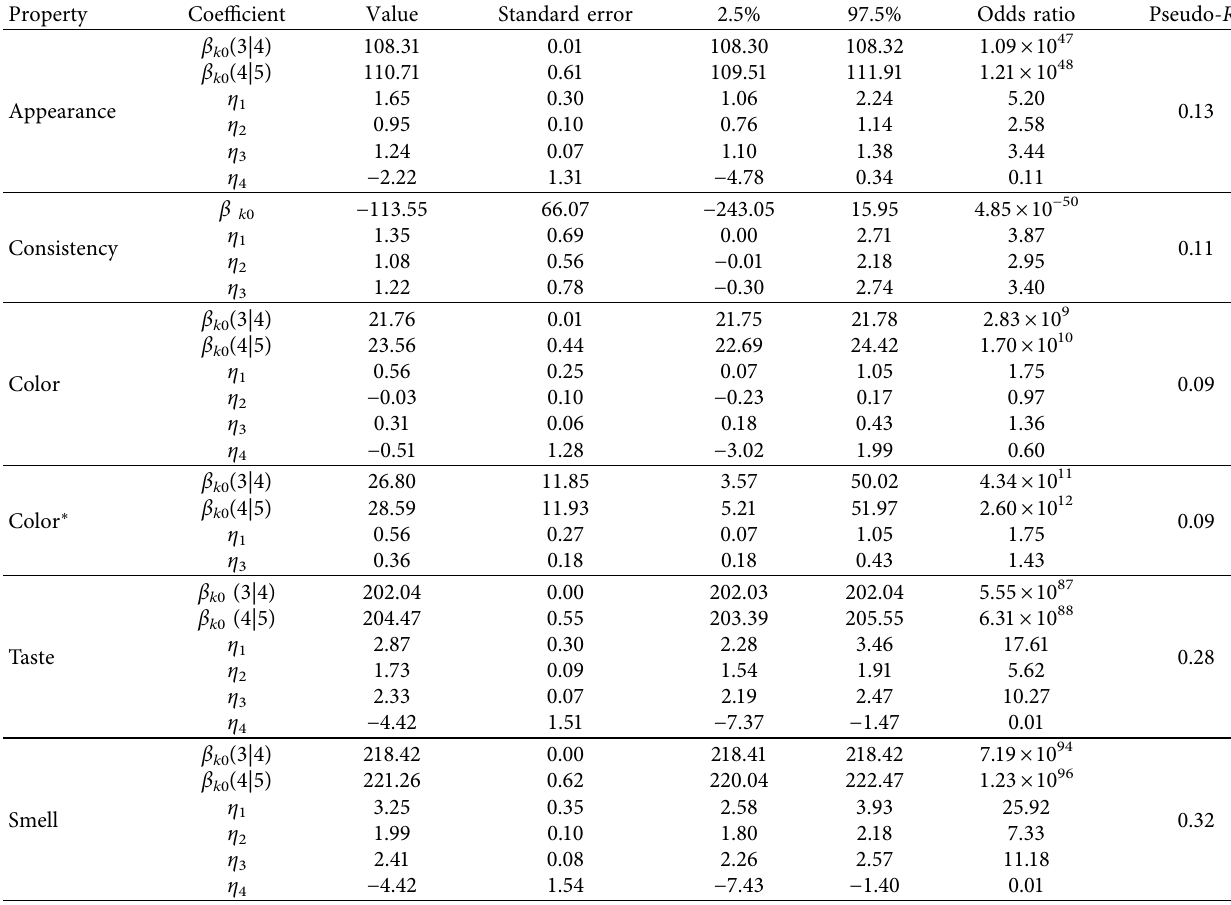
Table 5: Results of the multinomial ordered logistic regression